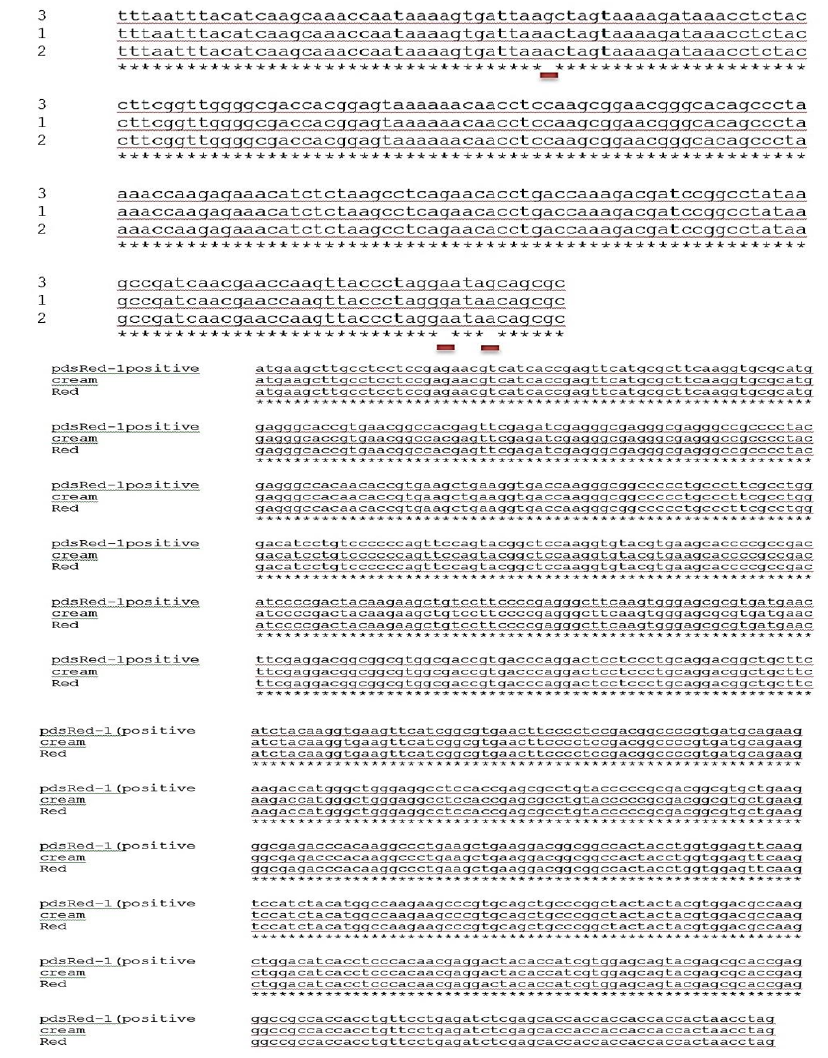
Fig. 3. Multi-alignment of sequences: (A) Multialign of three sequence amplified for 16S rDNA mitochondrial gene for zebrafish species detection; this sequences showed all of fish belong to zebra danio. Three different genotypes for zebra fish were amplified for 16S rDNA in our research and marked by red lines in this figure. (B) Multialign sequences of three different dsRed amplified by polymerase chain reaction in pdsRed-1(positive control for dsRed) DNA, Red zebrafish specimens DNA and cream zebrafish specimens DNA (offspring of male and female red color).